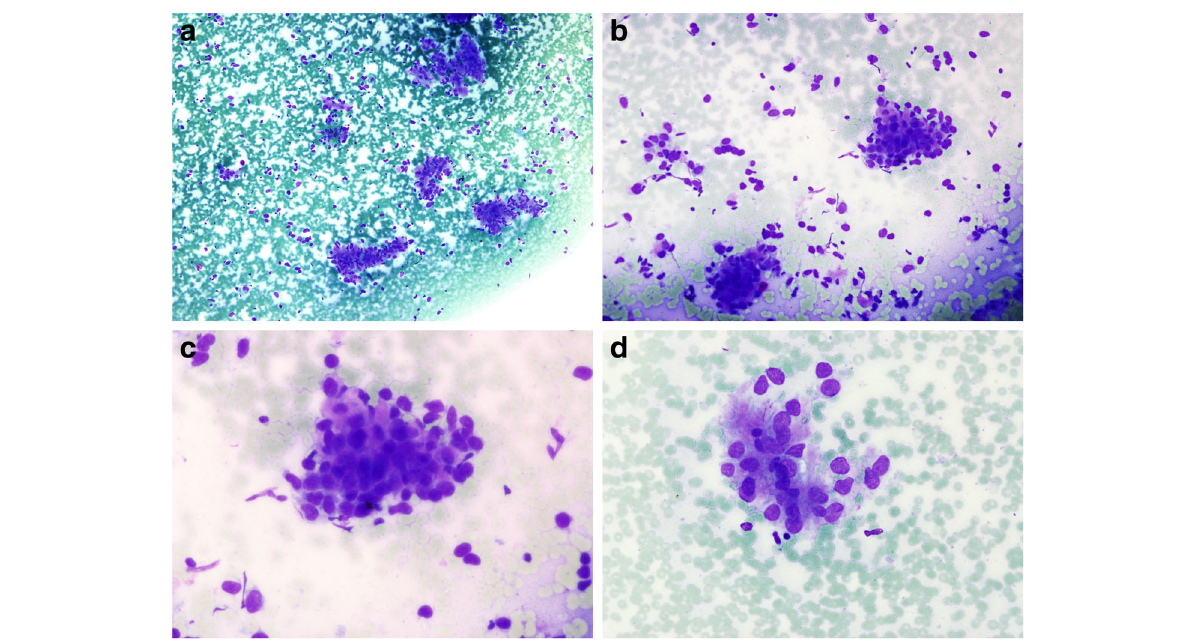
Fig. 1 Cytomorphology of find needle aspiration. a and ( b ) Moderate cellularity with cellular clusters and single cells (Liu ’ s stain, 100x and 200x). c Epithelioid cells with eosinophilic cytoplasm and naked nuclei with nulcer atypia (Liu ’ s stain, 400x). d A loosely cohesive cluster with pink myxofibrillary matrix(Liu ’ s stain,